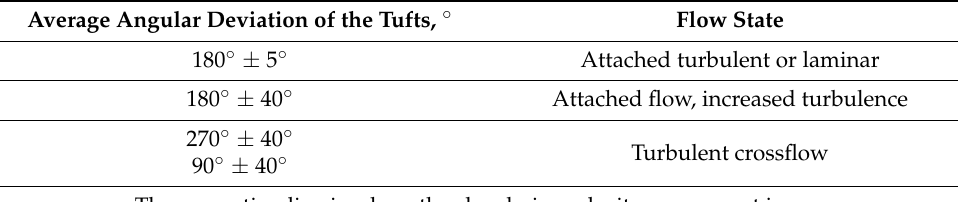
Table 2. Angular deviation of tufts as a flow state indicator 1 .